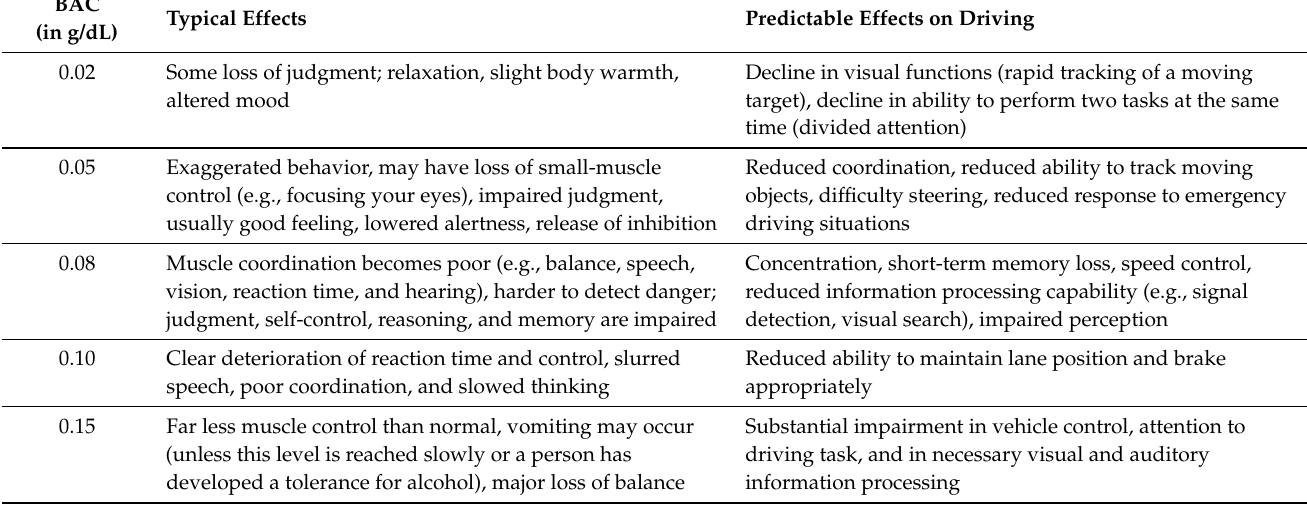
Table A3. This table gives the effects of blood alcohol concentration (BAC). It is a nearly-verbatim reproduction of a table present on the NHTSA website in mid